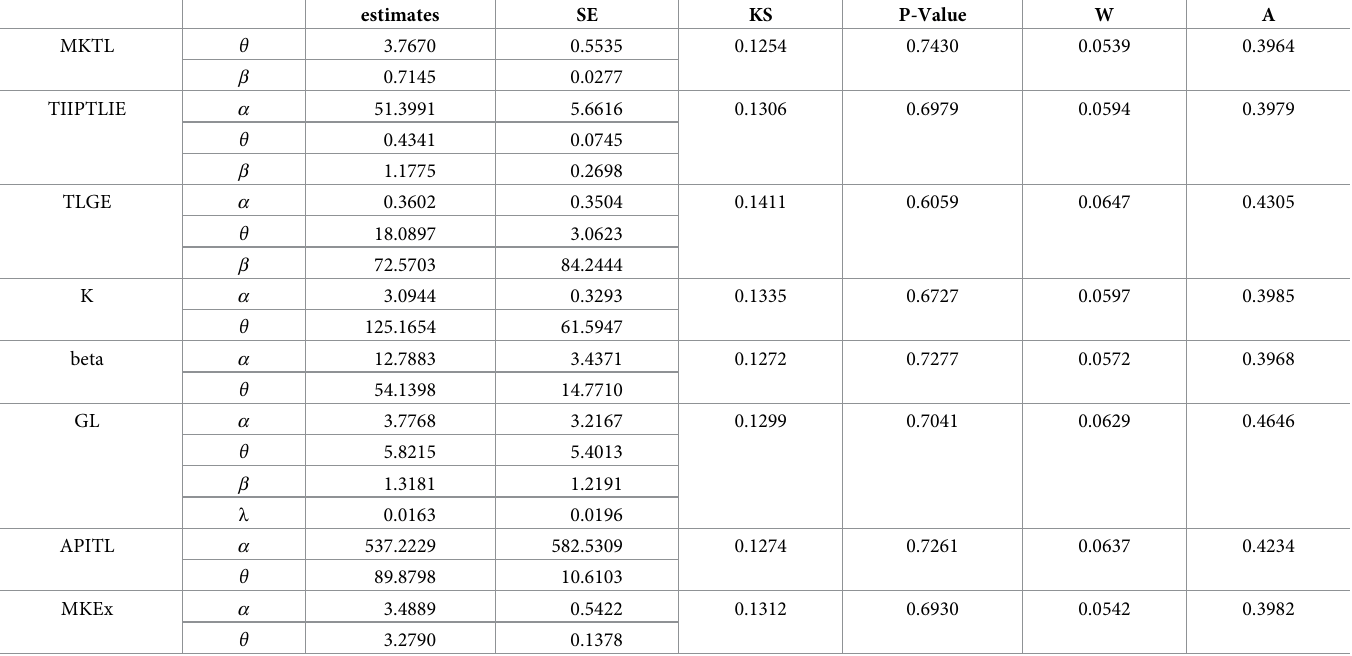
Table 5. Values of estimates and all fitting results for Saudi Arabia mortality